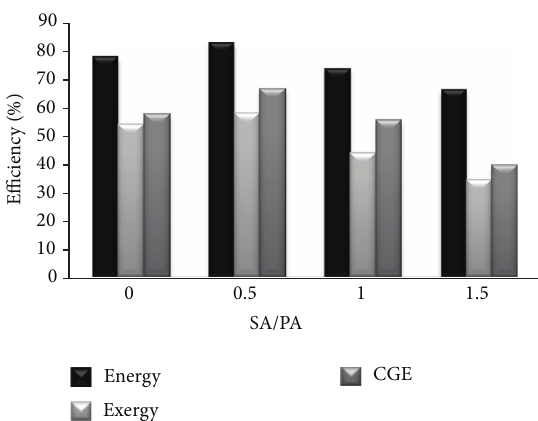
Figure5:Effectofsecondarytoprimaryairratiooncoldgas,energy and exergy